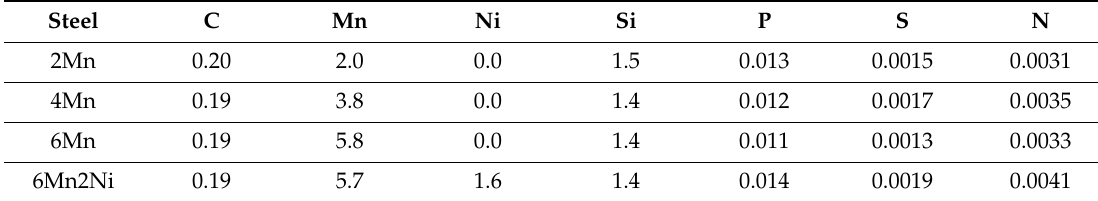
Table 1. Chemical composition of the steels (wt.%).